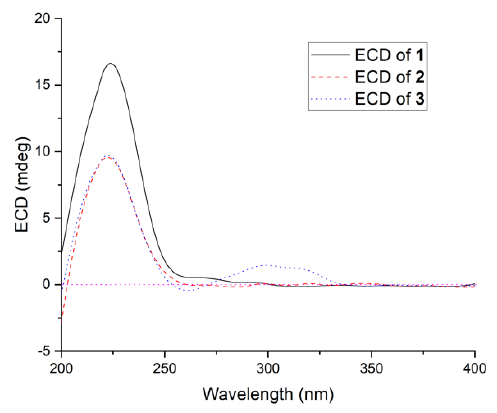
Figure 5. ECD spectra of compounds 1 – 3 . Steckwaic acid H ( 4 ) was determined to have the molecular formula C 18 H 26 O 3 based on the negative HRESIMS data. Its NMR data (Table 2) displayed typical signals of a decalin skeleton with three methyl signals for C-8, C-10, and C-15, and the appropriately modified acrylic acid substituent in 1 – 3 was changed to a penta-2,4-dienoic acid moiety in 4 . HMBC correlations from the olefinic proton H-13 to C-7, C-11, and C-15, as well as from H-6 and H-14 to the nonprotonated olefinic carbon C-12, were located in the position of a double bond between C-12 and C-13. In addition, HMBC correlations from the oxymethine proton H-14 to C-6, C-12, and C-18 confirmed the hydroxy-substituent at C-14. Large coupling constants between H-2 and H-3 ( J = 15.3 Hz), as well as H-4 and H-5 ( J = 15.1 Hz), showed the E -geometry of two double bonds at C-2 and C-4. The relative con- figuration of 4 was determined by a NOESY spectrum. NOE correlations from H-5 to H-7, H-14, H 3 -16, and H 3 -17 placed them on the same face of the molecule, whereas correlations from H-8 to H-10 indicated these protons were on the other side. To clarify the absolute configuration of 4 , the ECD spectra of minimum energy conformers by the TDDFT method at BH&HLYP/TZVP and CAM-B3LYP/TZVP levels were calculated, and the ex- perimental ECD spectrum of 4 matched well with that of the calculated spectrum for (6 R , 7 R , 8 R , 10 S , 14 S , and 15 R )- 4 (Figures 6 and S59). Table 2. 1 H and 13 C NMR data of compounds 4 – 6 in DMSO- d 6 . No.